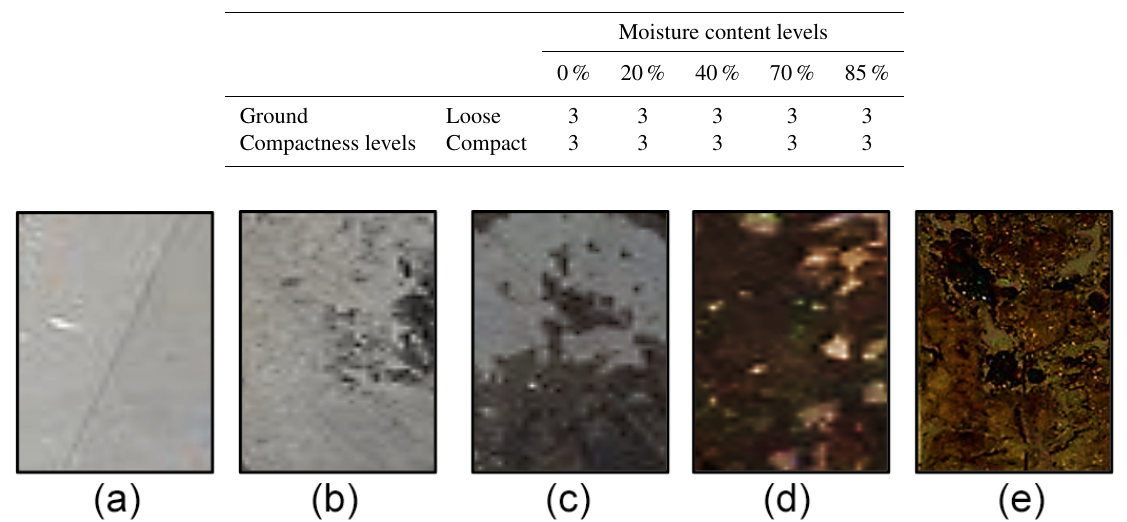
Table 1. Organization of tests. The numbers of tested ground samples for each MC and ground compactness level are reported.